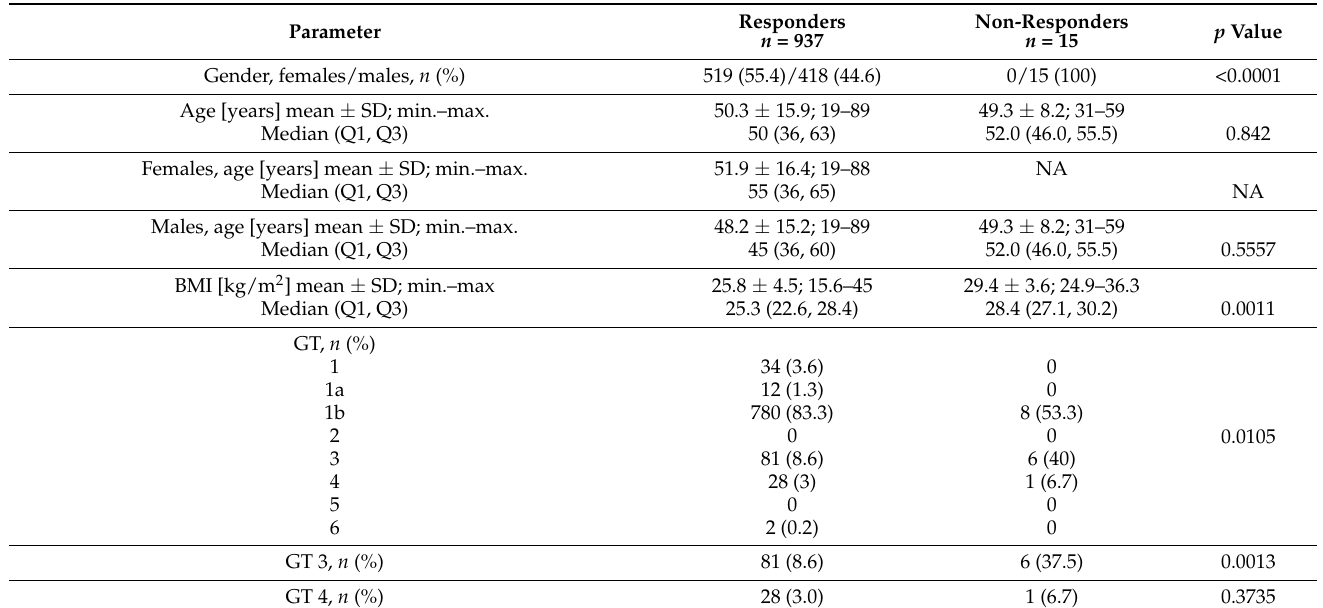
Table 5. The Comparison of Virological Responders and Non-Responders to Antiviral